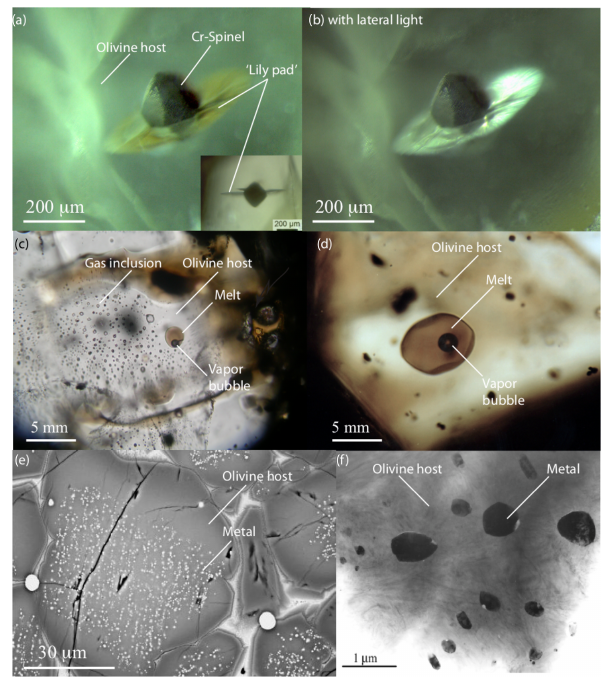
Figure 11. Inclusions in olivine: (a, b) optical microphotographs of a spinel inclusion and lily-pad-like cracks in San Carlos olivine; (c, d) optical microphotographs of melt inclusions in magmatic olivines from Piton de la Fournaise (from Bureau et al., 1998; im- ages courtesy of Hélène Bureau); and (e) scanning electron micro- scope image and (f) TEM image of metal bleb inclusions in dusty olivines (from Leroux et al., 2003; images courtesy of Guy Libourel and Hugues